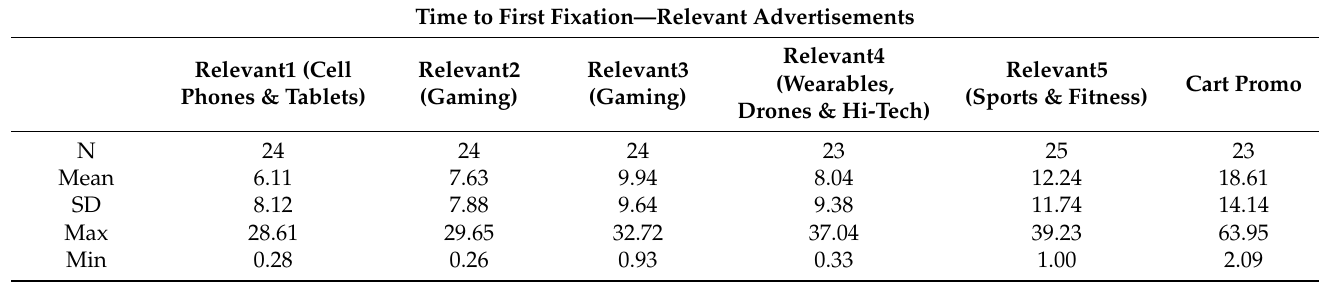
Table 4. Time to first fixation of relevant advertisements.